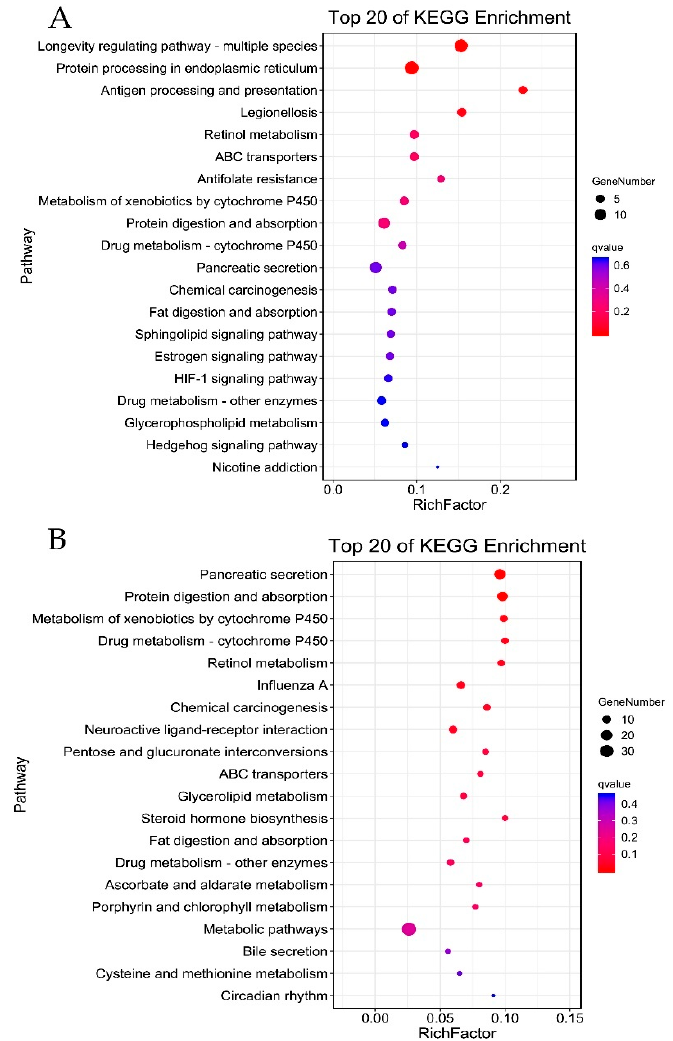
Figure 3. Top 20 KEGG pathways enrichment bubble chart, ( A ) ACB-FR vs. ACB-BtS; ( B ) ACB-IeR vs. ACB-BtS. The vertical axis is the pathway name, and the horizontal axis is the rich factor (the ratio of differentially expressed genes to all annotated genes in the pathway). The size of q -value is represented by the color of the point. Additionally, the smaller the q -value, the deeper of the red color. The size of the bubble indicates the number of differential genes contained in each pathway.